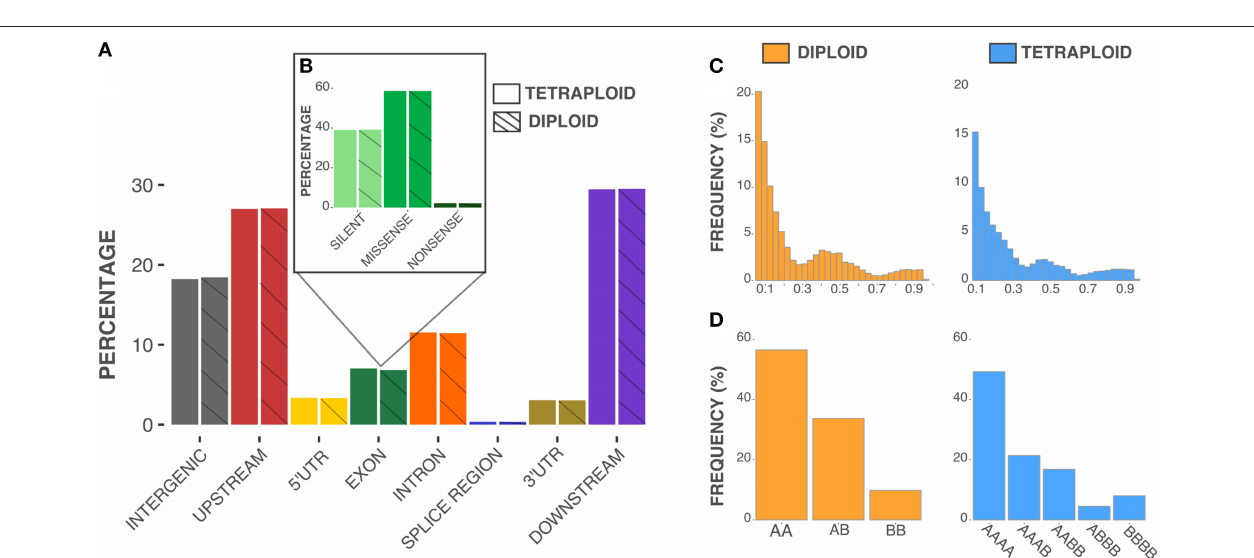
apart for the diploid model and 80 Kb apart for the tetraploid model (Supplementary Figure 1). In order to verify the possible influence of the population structure in the GWAS analysis, we performed PCA and DAPC cluster analyses. The results for both